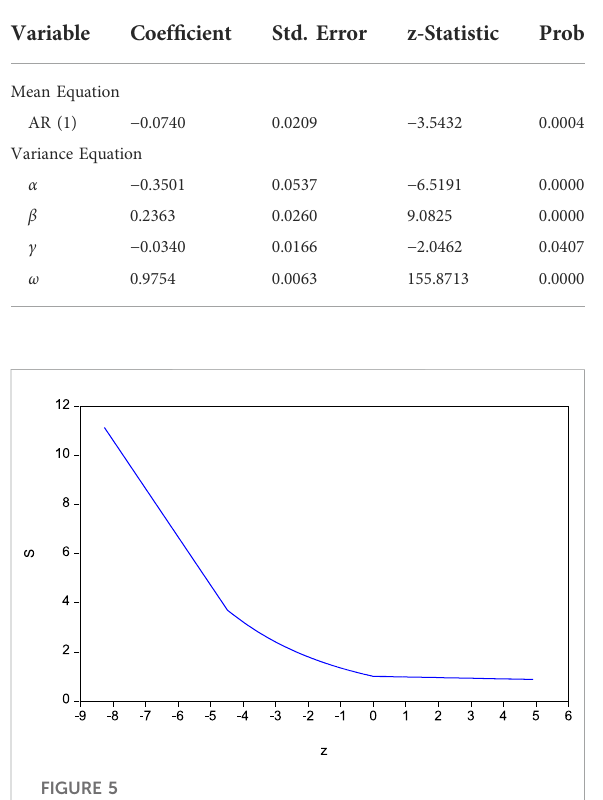
TABLE5EstimationresultsoftheEGARCH(1,1)modelforEUAfutures returns from 1 January 2013, to 31 December 2020.